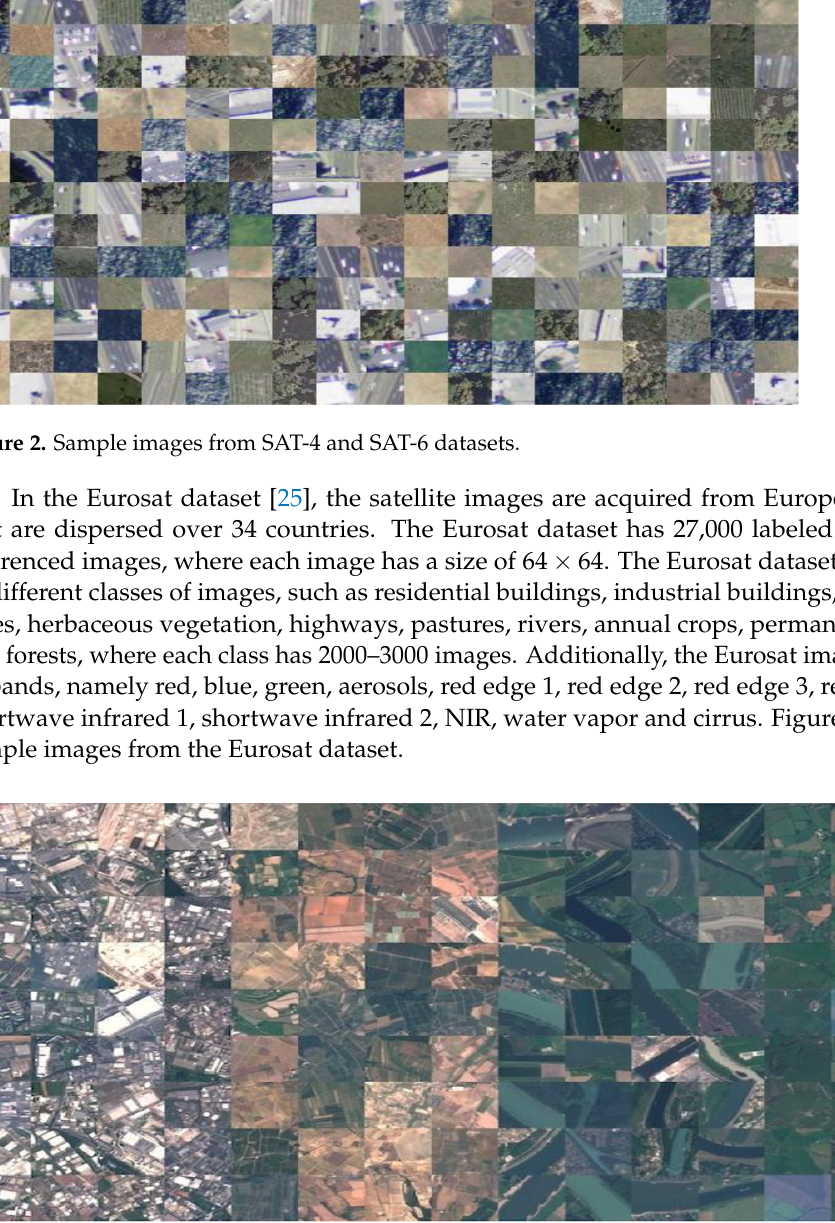
Figure 3. Sample images from Eurosat